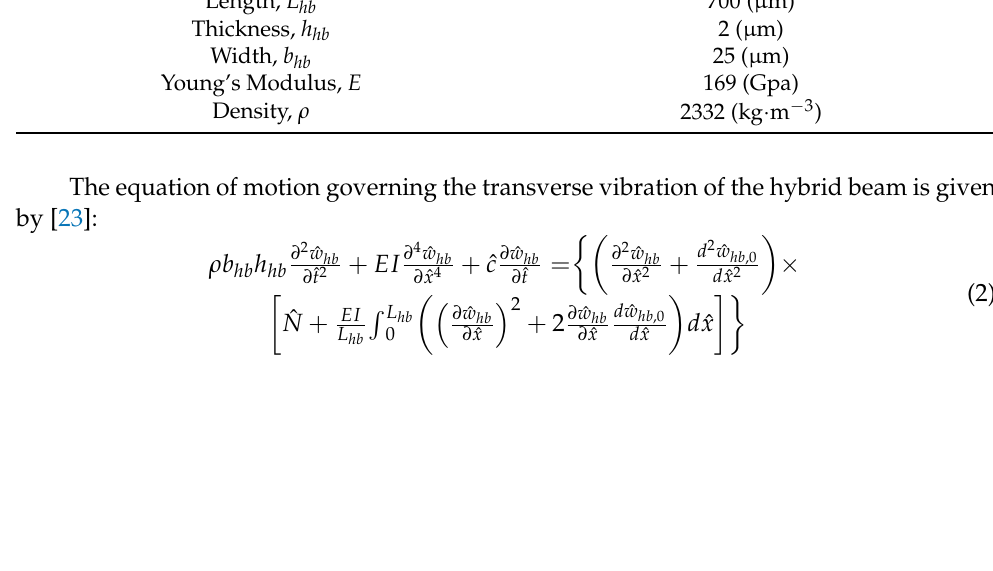
Table 1. Geometrical and mechanical properties of the silicon hybrid MEMS resonator.